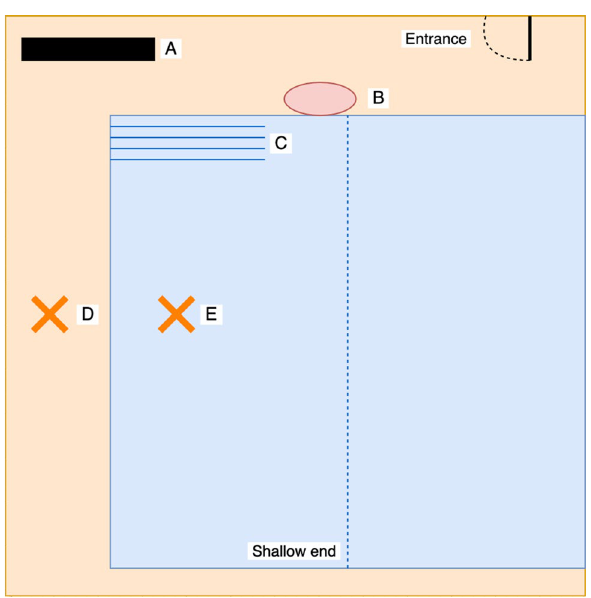
Figure 5. Bird’s eye view of the pool where the study was conducted. The participants reached the deck of the pool through the entrance and walked toward the bench ( A ) where they completed the pre-survey. Participants assigned to the Ground condition were invited to walk to the orange mark on the ground ( D ) where they started their VR experience. Participants assigned to the Water condition were first invited to go to the edge of the pool ( B ) where the researcher in charge of the Water condition briefed them and presented the equipment. The participants then entered the water through the stairs ( C ) and swam to the orange mark ( E ) where they started their VR